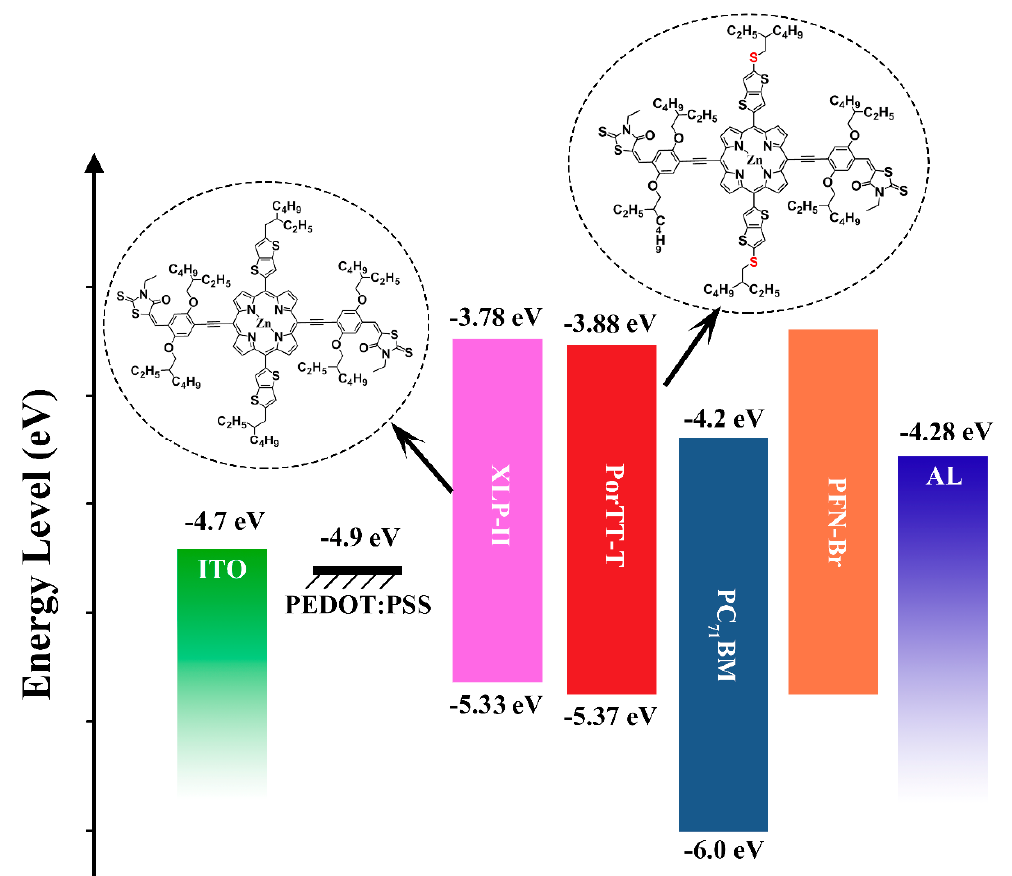
Figure 1. Molecular structure of PorTT-T and XLP-II, and the energy levels of the layers of the device.